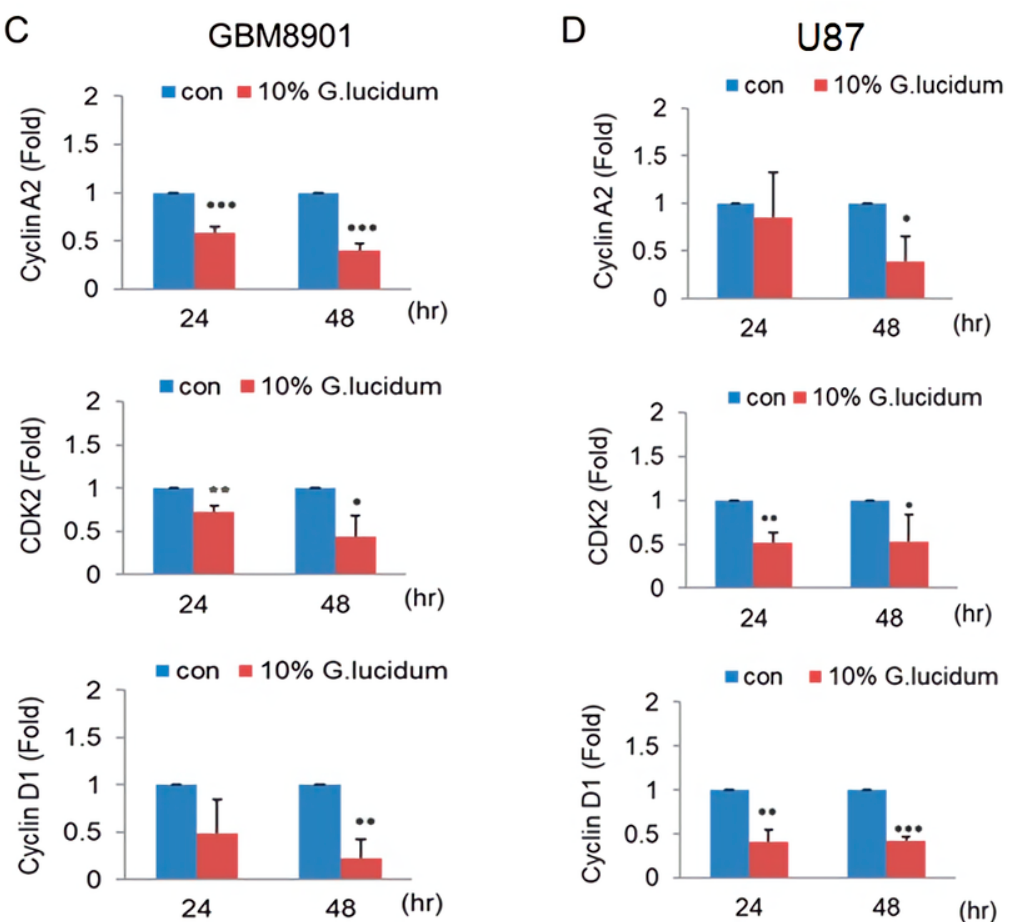
Figure 4. G. lucidum extract downregulates the expression of S phase-related proteins. ( A , B ) The expression of the indicated S phase-related proteins in ( A ) GBM8901 and ( B ) U87 cells was determined by Western blotting. ( C , D ) Quantification of protein expression from Western blots of ( C ) GBM8901 and ( D ) U87 cells as shown in A and B by ImageJ. * p < 0.05; ** p < 0.01; *** p < 0.001.